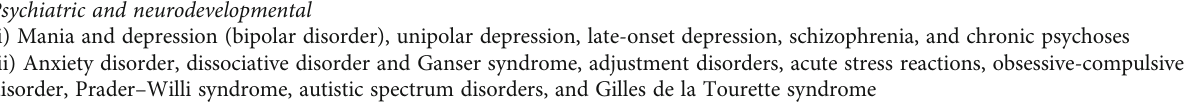
Table 1: Causes of catatonia (adapted from Jaimes-Albornoz and Serra-Mestres [1]). Psychiatric and